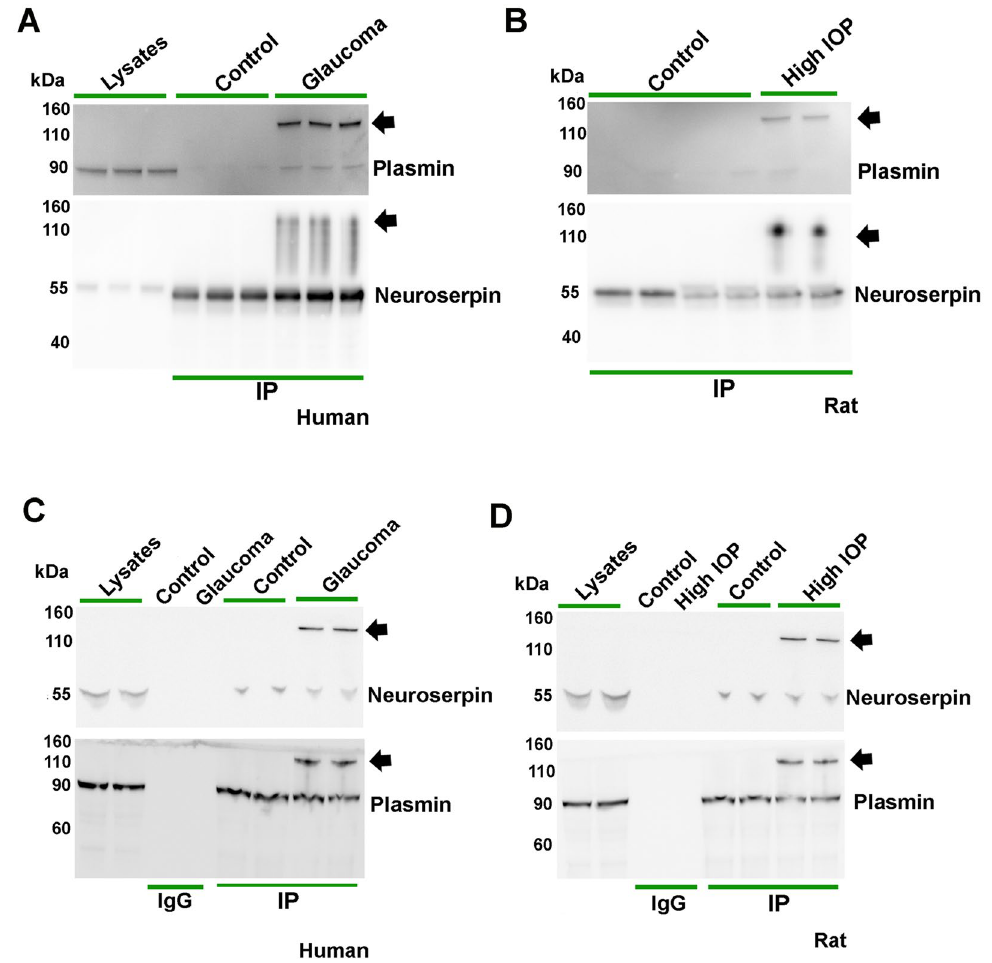
Figure 6. Neuroserpin was immunoprecipitated from ( A ) control and glaucoma human and ( B ) control and high IOP rat retinas. The eluted immunoprecipitates were subjected to western blotting and probed using plasmin and neuroserpin antibodies. Human retinal lysates alone were also loaded as controls. Plasmin was immunoprecipitated from ( C ) human and ( D ) rat retinal lysates from control and glaucoma samples along with corresponding IgG control immunoprecipitations. Human and rat retinal lysates respectively were loaded in C and D. After elution, the immunoprecipitates were subjected to western blotting and probed using plasmin and neuroserpin antibodies. High molecular weight bands (indicated by arrow) implicating neuroserpin-plasmin complex formation were observed in both human and rat glaucomatous retinal samples. Blots were cropped to show the relevant